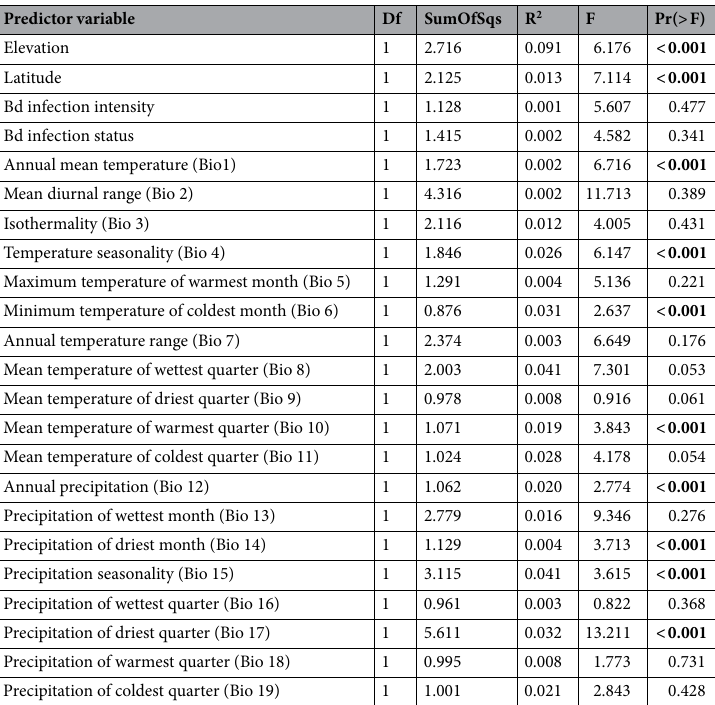
Table 1. Results of permutation multivariate analysis of variance (PERMANOVA) to examine the effect of selected predictor variables on beta diversity of amphibian skin microbiome in treefrogs of the Brazilian Atlantic Forest. PERMANOVAs on Bray–Curtis distances with 9999 random